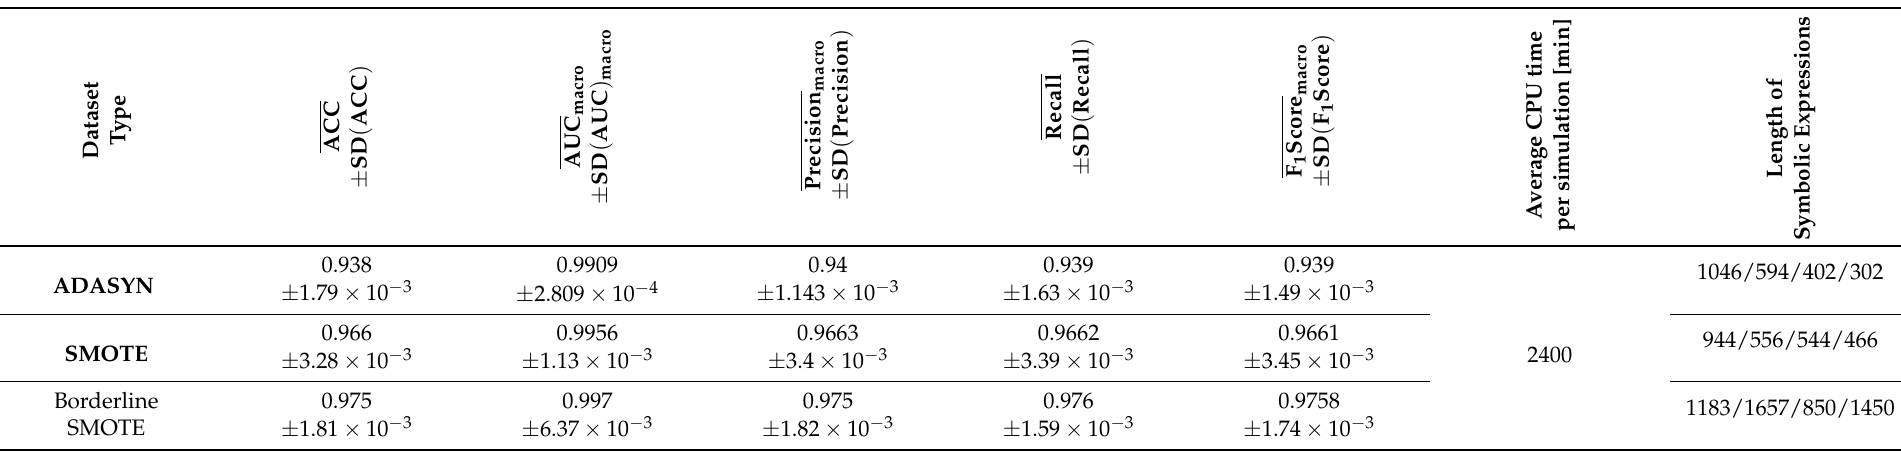
Table 4. The mean and standard deviation values of ACC , AUC , Precision , Recall , and F 1- Score obtained with the best symbolic expressions in each dataset